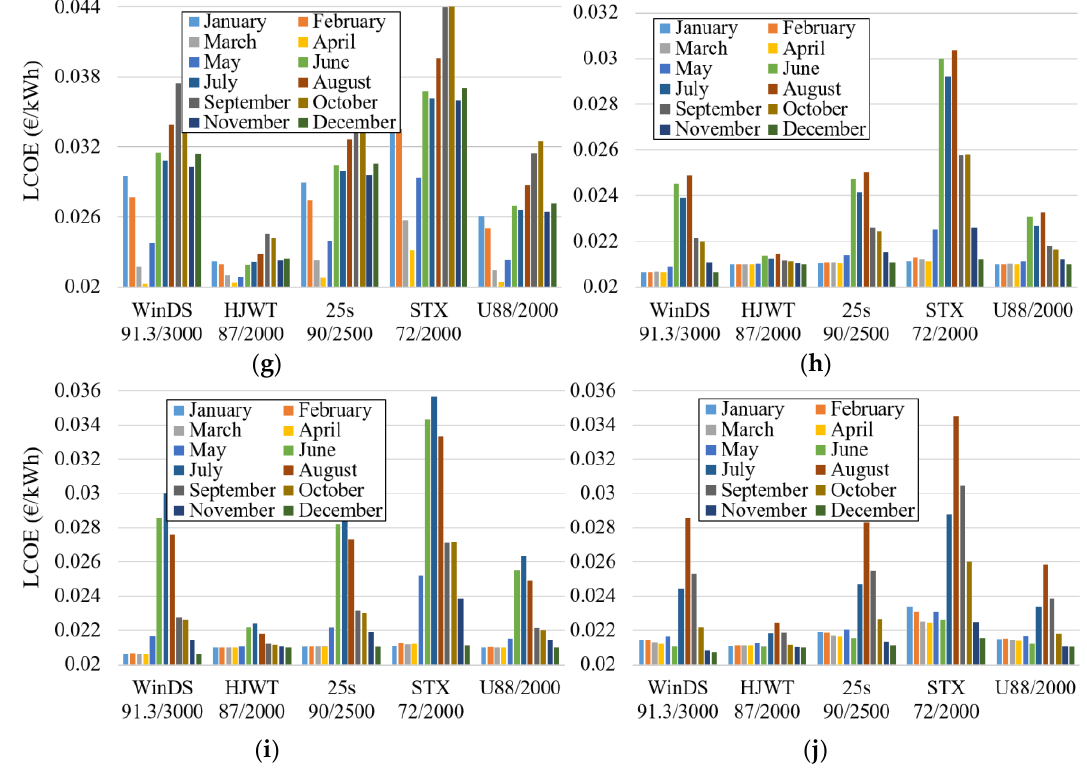
Figure 14. Estimation of NPV at newly proposed wind farm sites ( a ) Site 1; ( b ) Site 2; ( c ) Site 3; ( d ) Site 4; ( e ) Site 5; ( f ) Site 6; ( g ) Site 7; ( h ) Site 8; ( i ) Site 9; ( j ) Site 10 .